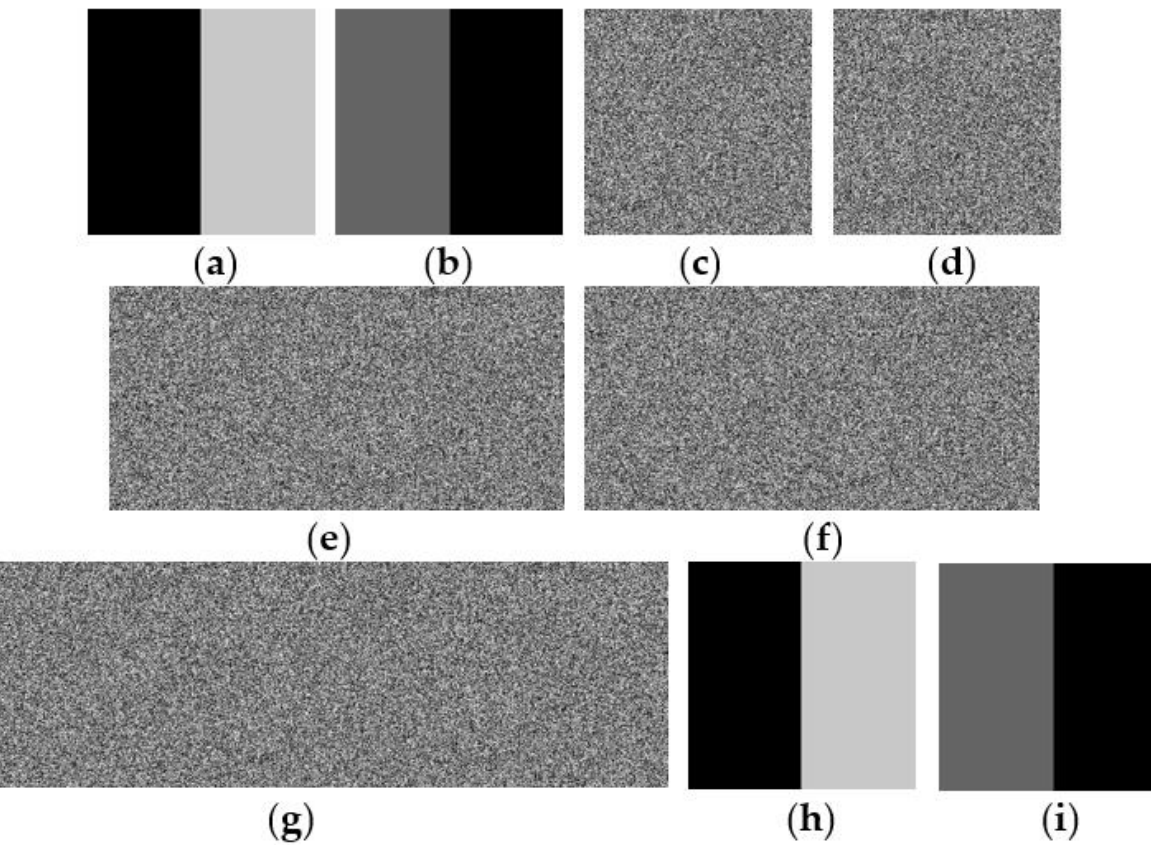
Figure 7. A sharing example of the proposed (2, 3, 2) SRS method: ( a , b ) two secret images, ( c , d ) two encrypted images, ( e – g ) shared images, ( h , i ) the recovered images from ( e , f ). The sharing processes of the proposed (2, 3, 2) SRS method is introduced as follows.